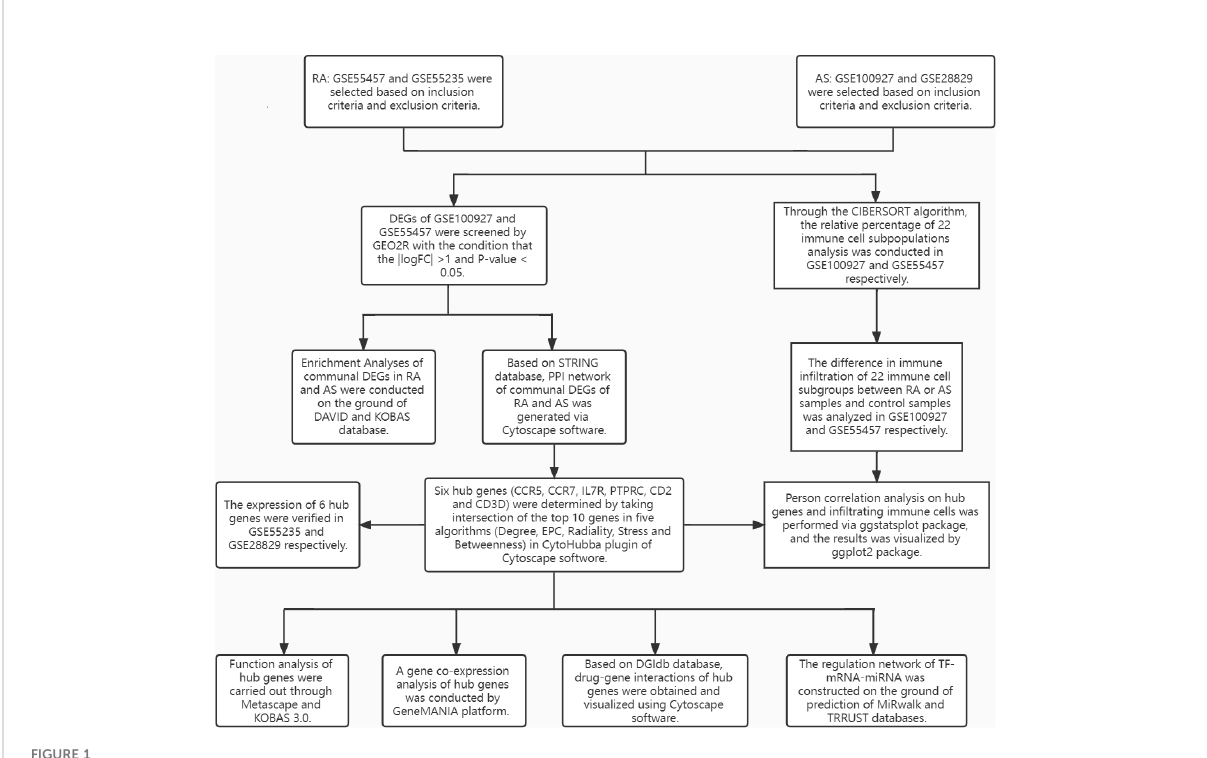
FIGURE 1 The research design fl